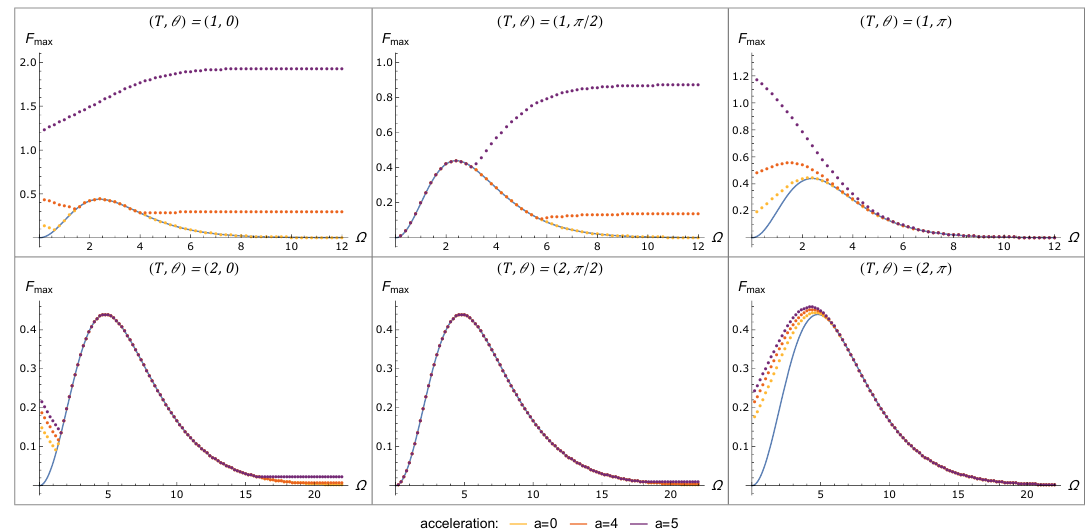
Figure 4 . (Approximate) temporal maximum of the Fisher information in dS. Every panel corre- sponds to a different choice of ( T, θ ) . Again, the three colors correspond to different accelerations. The asymptotic Fisher information computed in the previous section is also shown in a solid